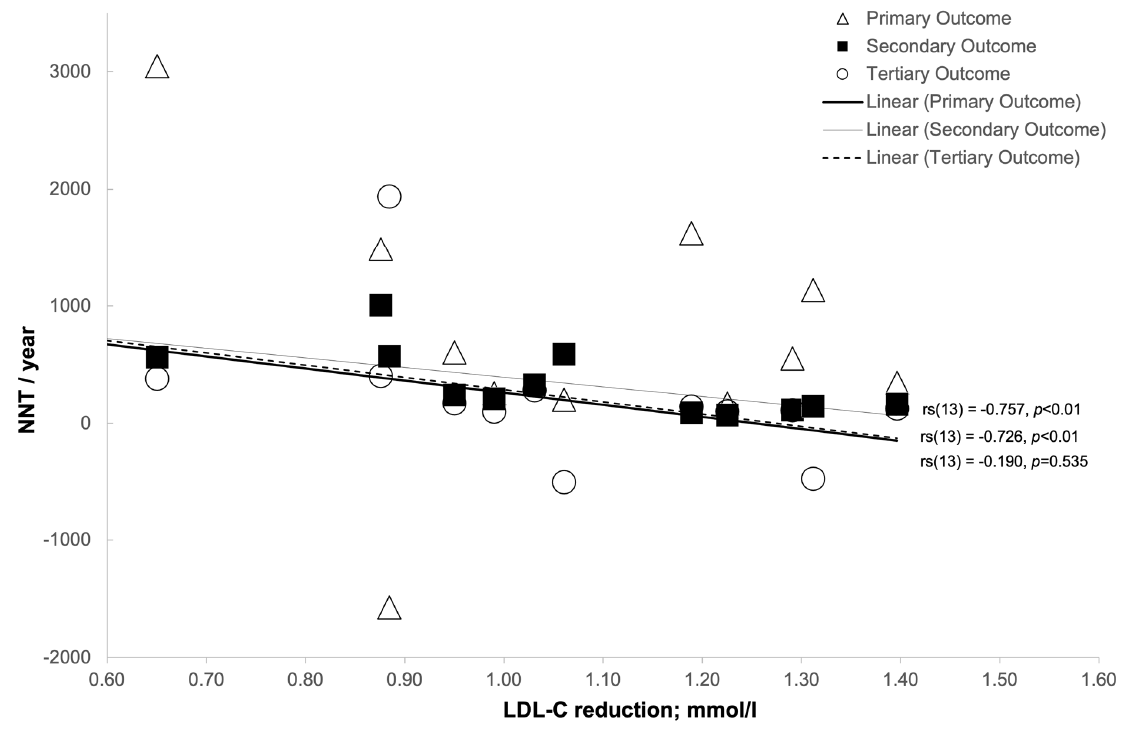
Figure 10. The relationship between LDL-C reduction (mmol/L) and number-needed-to-treat (NNT)/year.